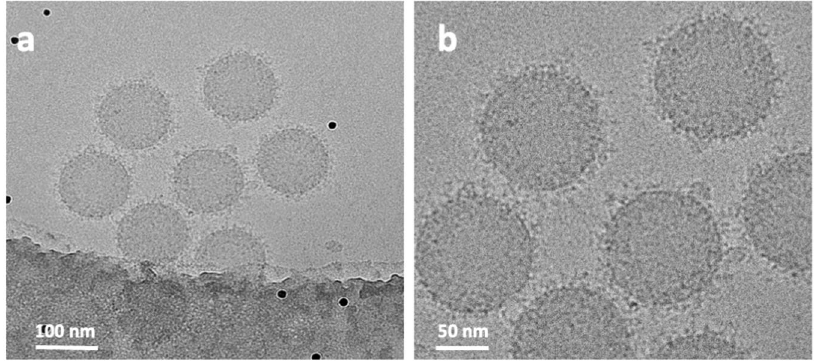
Fig. 5 Cryo-EM images of amino PS-NPs taken with the Falcon 2 direct electron detector (DED) and phase plate. a Lower magni fi cation shows of the distribution of the biomolecules, and b higher magni fi cation revealing their associations with the surface of